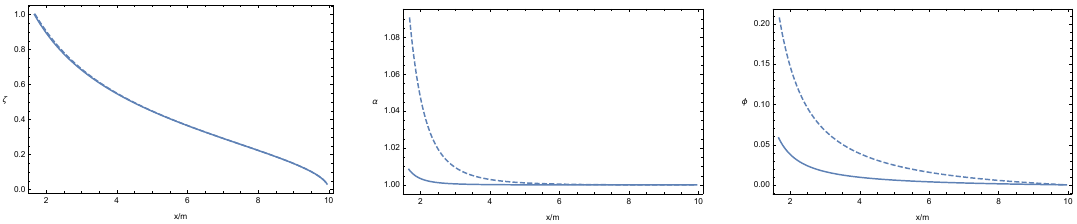
Figure 3 . The spacetime configurations of the static HBHs with m = 1 . 03424 , Q s = 0 . 225 (dashed curves) and m = 1 . 1594 , Q s = 0 . 0615 (solid curves), corresponding to the filled circle and square, respectively, in figure 2. The left, middle, and right panels show the metric functions, ζ ( r ) and α ( r ), as well as the scalar field φ ( r ) as functions of x/m